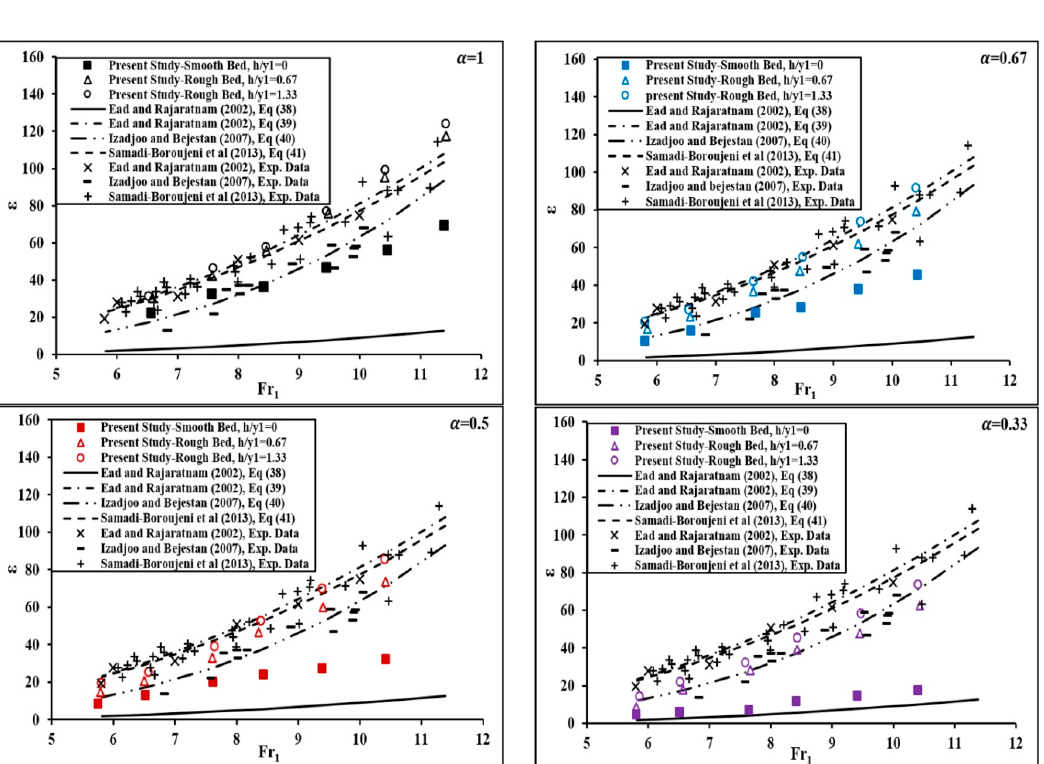
Figure 21. The bed shear stress coe ffi cient as a function of upstream Froude number for two relative roughness heights ( h / y 1 = 0.67 and 1.33) and di ff erent expansion ratios ( α = 0.33, 0.5, 0.67, 1) with asymmetry ratio of ∆ = 0.16.